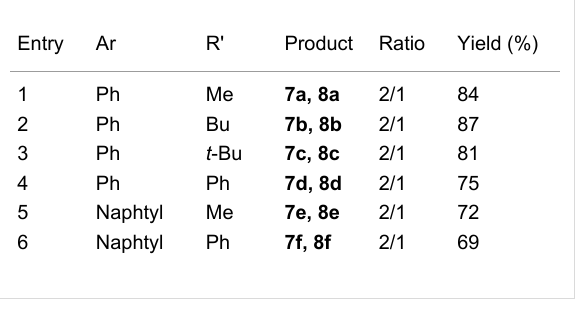
Table 2: Results of 3-substituted and 2-substituted